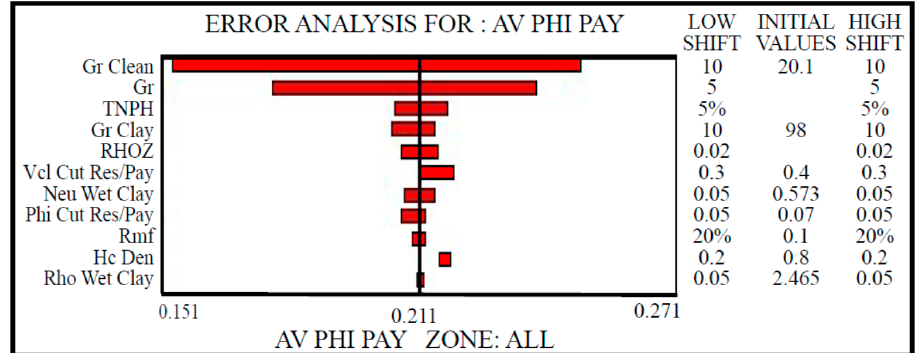
Figure 3. A Tornado plot for average porosity calculations in well ND-1.